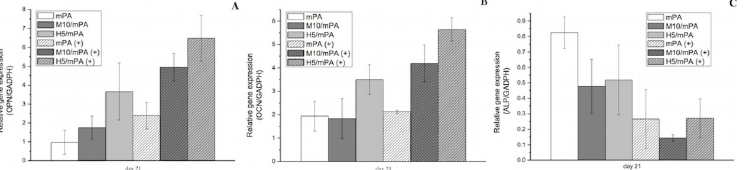
Fig 9. Real time RT-PCR analysis of (A) OPN, (B) OCN, and (C) ALP gene expressions on day 21 with the application of a moving magnetic field. GAPDH was used as the housekeeping gene. The representation “+” means applied the moving magnetic